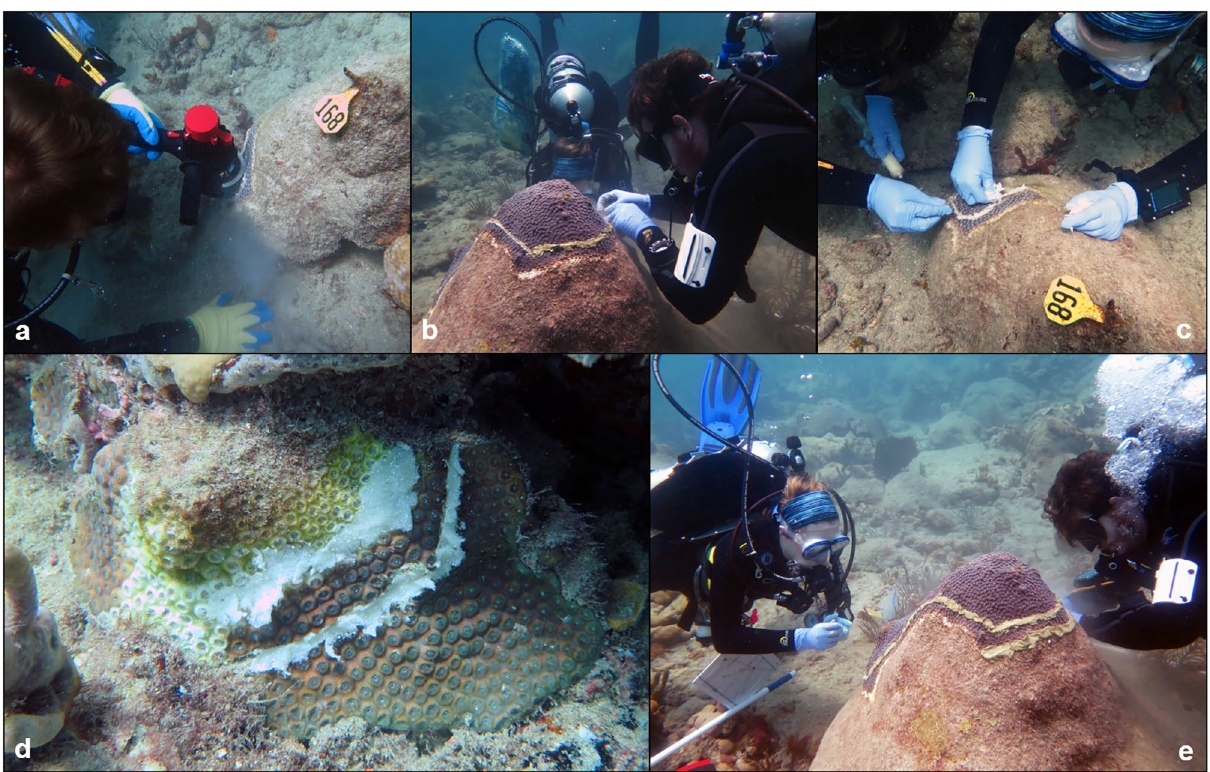
Figure 2. Step-by-step process of treating SCTLD-affected coral colonies in situ. ( a ) Diver creating a trench around the SCTLD lesion using an angle grinder. ( b ) Filling a trench with the chlorinated epoxy treatment. ( c ) Filling a trench with the Base 2B plus amoxicillin mixture. ( d ) A SCTLD-affected coral colony that has been treated with the Base 2B plus amoxicillin mixture. ( e ) A SCTLD-affected coral colony partially treated with the chlorinated